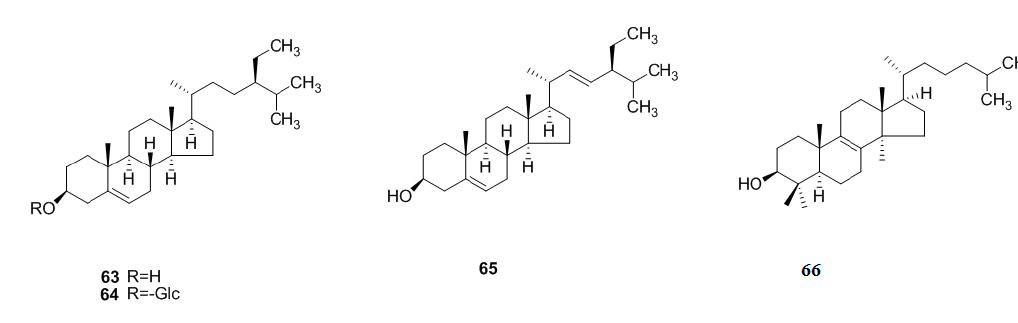
Figure 6. Chemical structures of steroids in C. pinnatifida